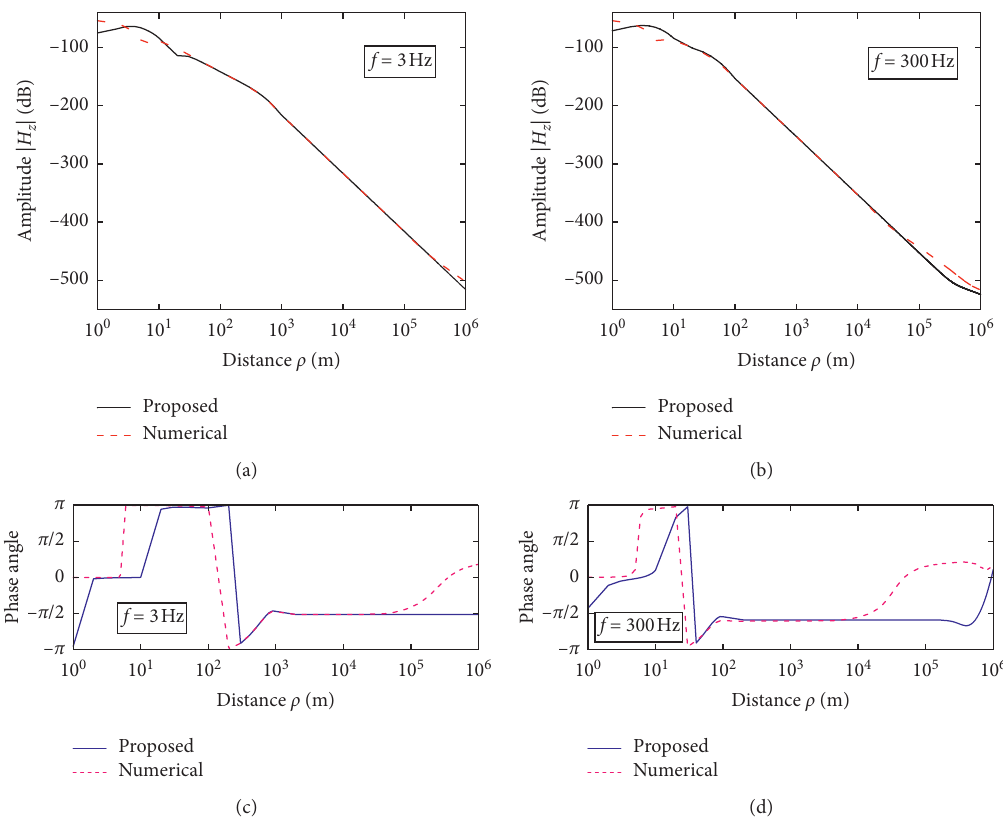
versus the propagation distance ρ with the proposed and numerical 2 z